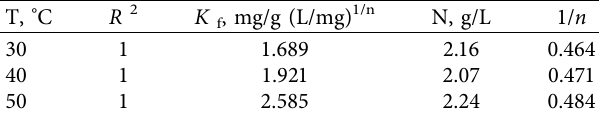
Table 6: Freundlich isotherms for Pb ions adsorption. T, ° C R 2